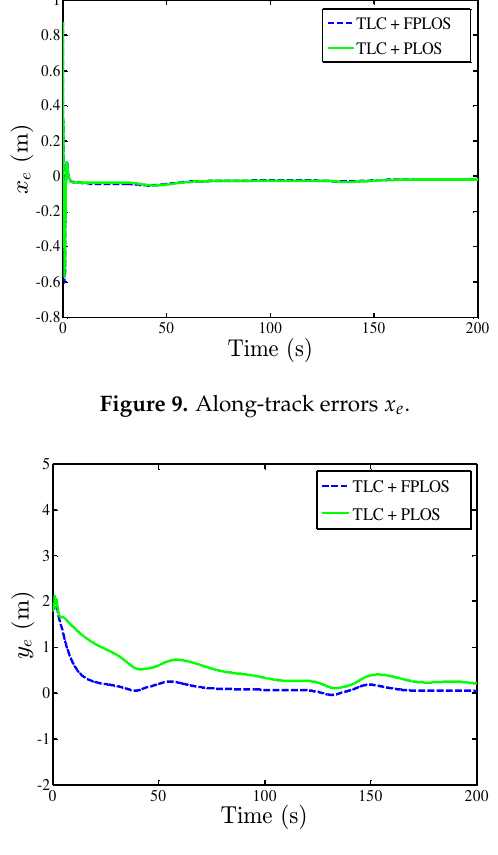
Figure 10. Cross-track errors y e